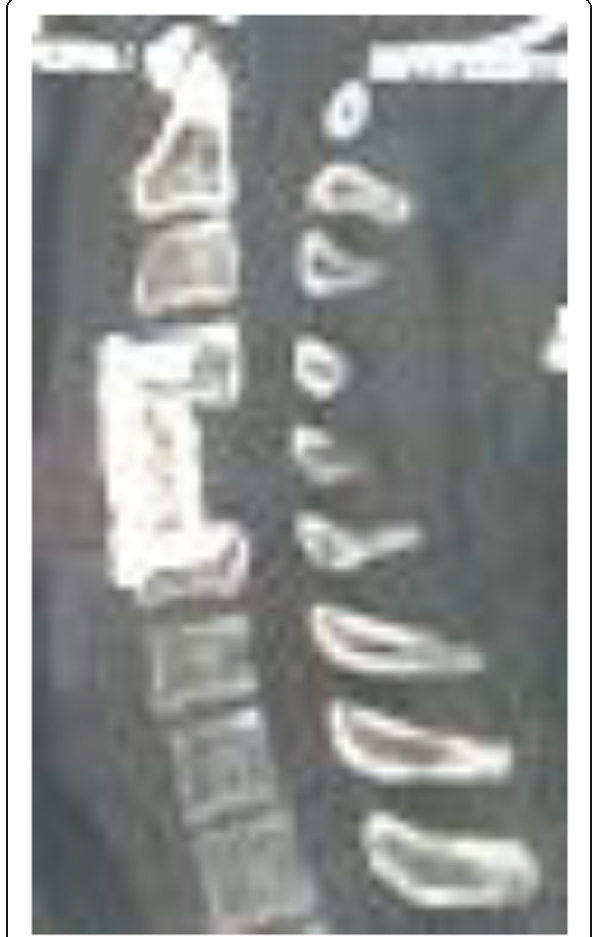
Fig. 4 C5 corpectomy, mesh graft, and C4 – C6